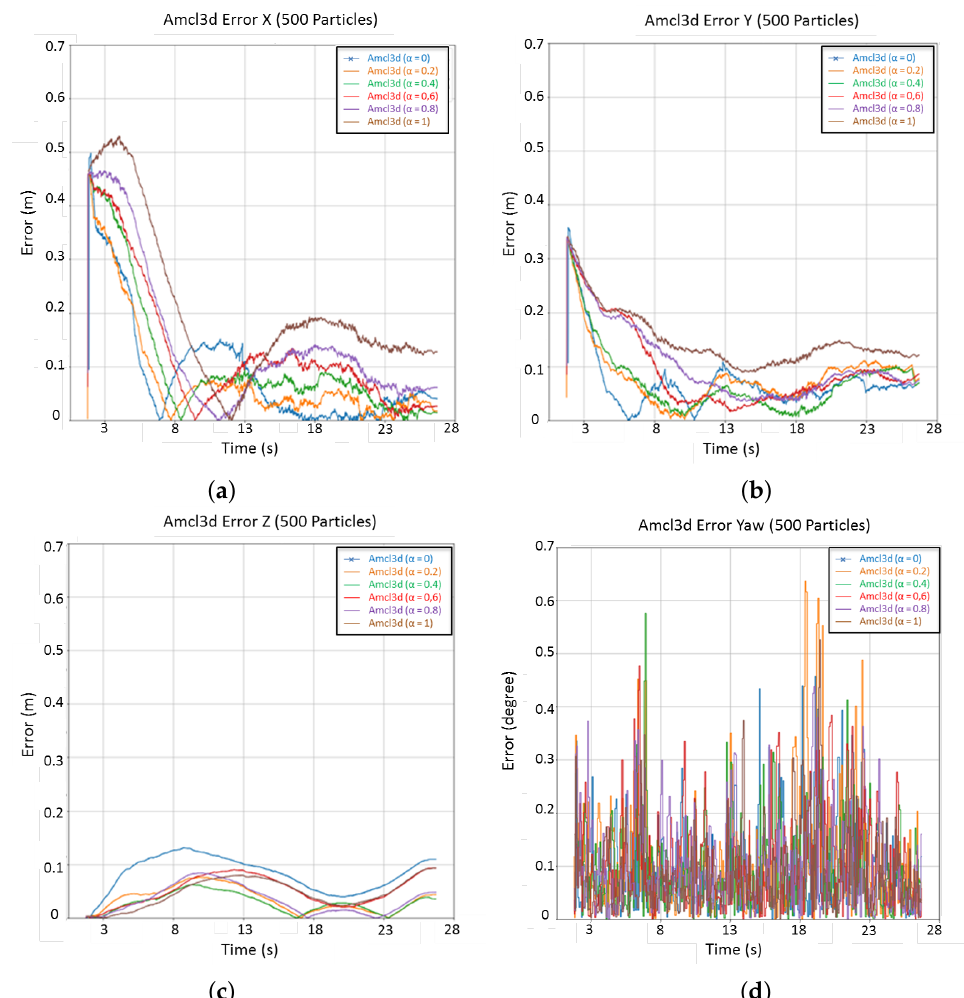
Figure 9. Error plots using 500 particles: ( a ) errors in X, ( b ) errors in Y, ( c ) errors in Z, ( d ) errors in yaw.